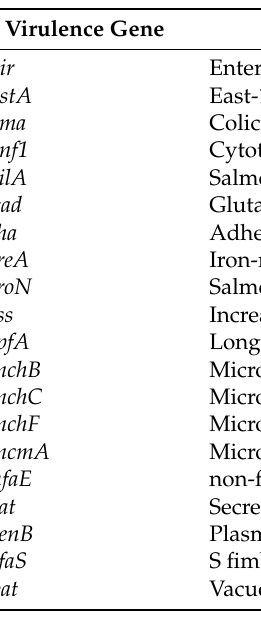
Table 2. Distribution of virulence genes in different E. coli.